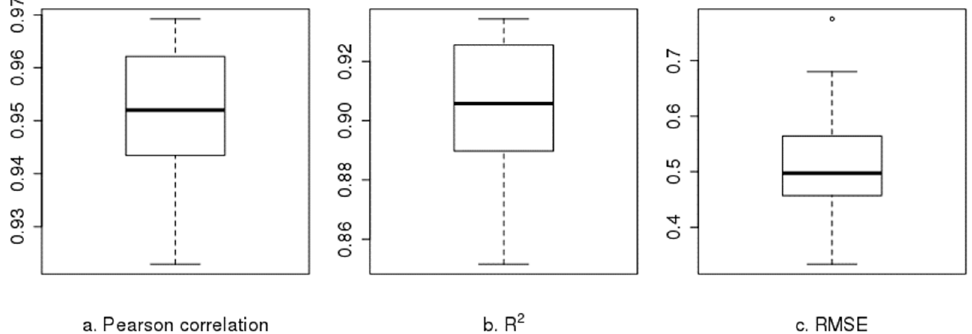
Figure 11. Boxplots of correlation ( a ), R 2 ( b ) and RMSE ( c ) between the averages of finely resolved grid cells (predicted) and the corresponding coarsely resolved grid cells (reanalysis data).